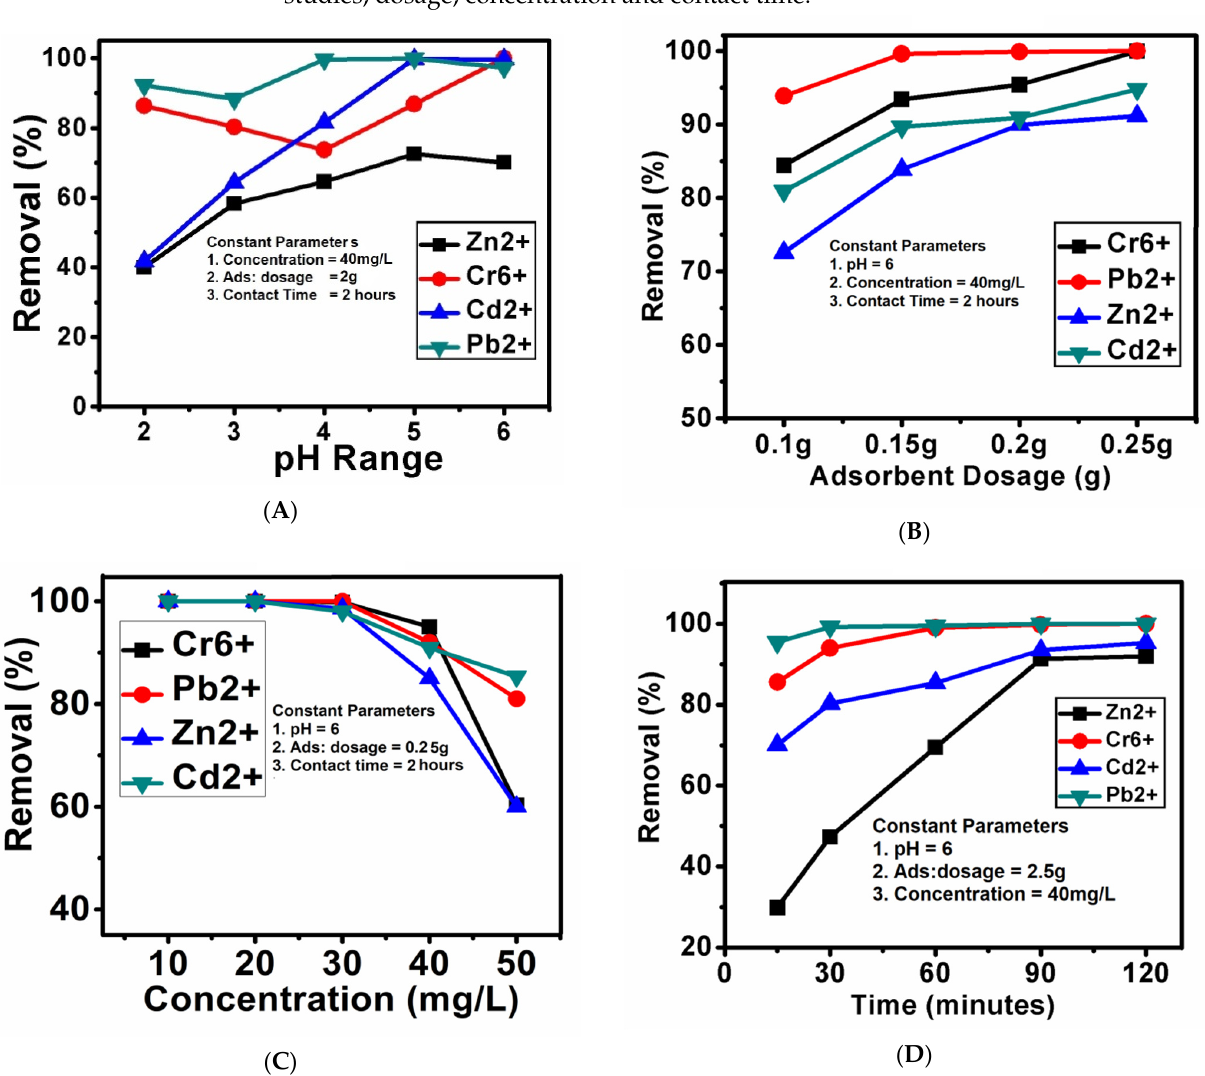
Figure 4. ( A – D ) The effects of different parameters; pH, adsorbent dosage, metal ion concentration and contact time on the percentage removal of the metal ions.